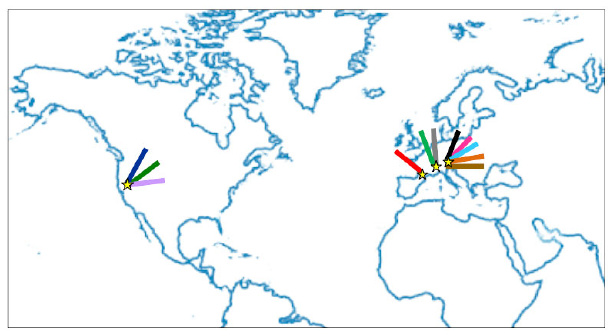
Figure 1. The map shows the approximate location of the 11 spatial snow depth data sets. The colors of the trays indicate the region, measurement platforms or acquisition date as presented in Fig.